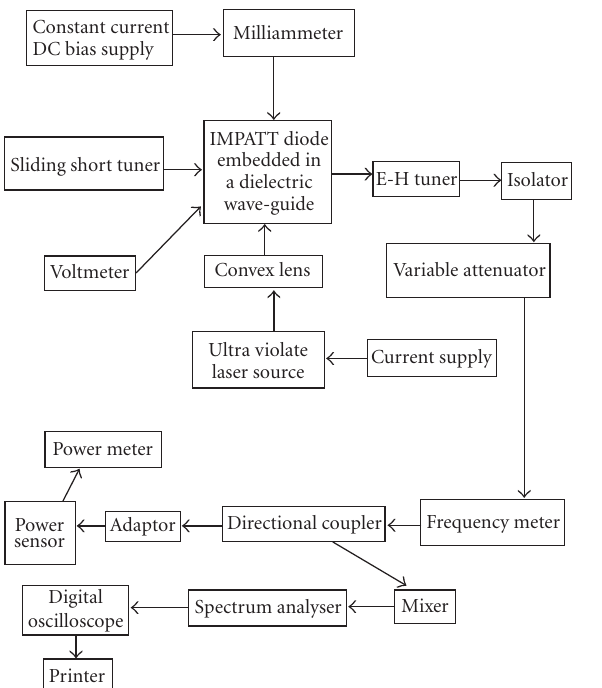
Figure 8: Experimental setup for optical illumination experiment on 4H-SiC IMPATT diode at THz region.